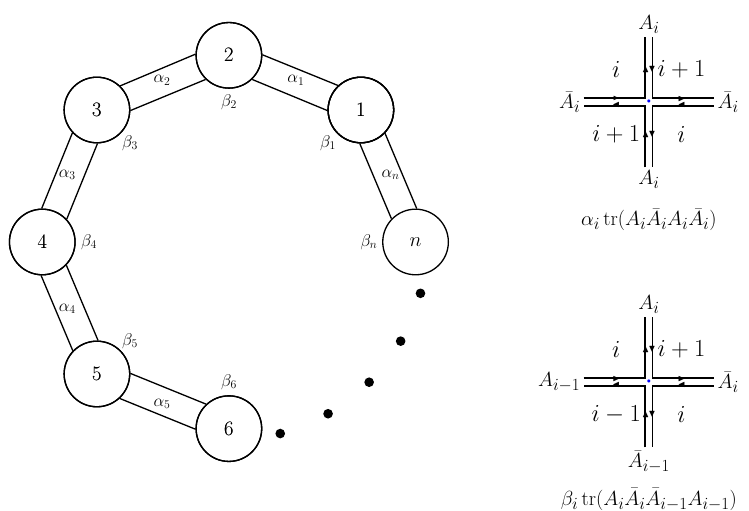
Figure 29 . Cyclic correlator and four-valent vertices dual to the BPS squares [ i ( i + 1) i ( i + 1)] and [ i ( i + 1) i ( i (cid:0)